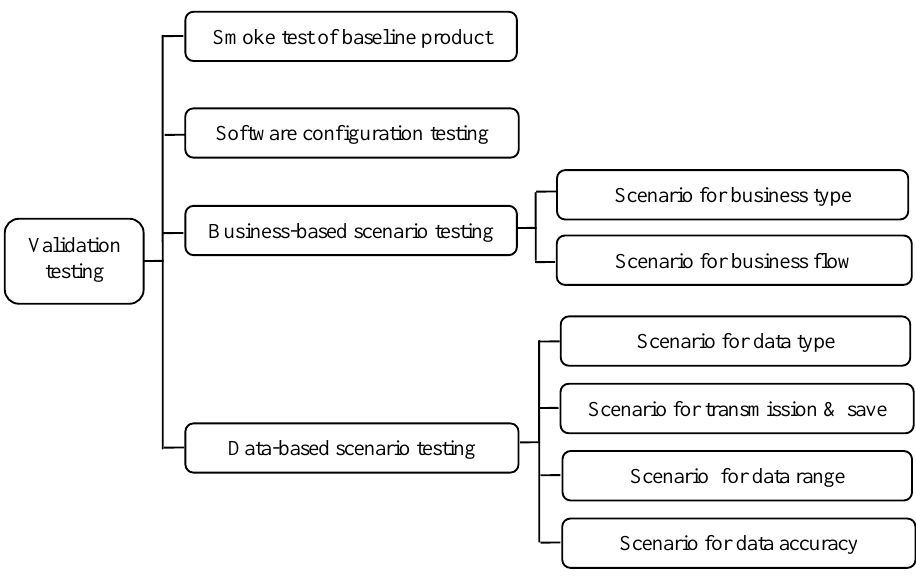
Fig. 3. Usual contents of validation testing